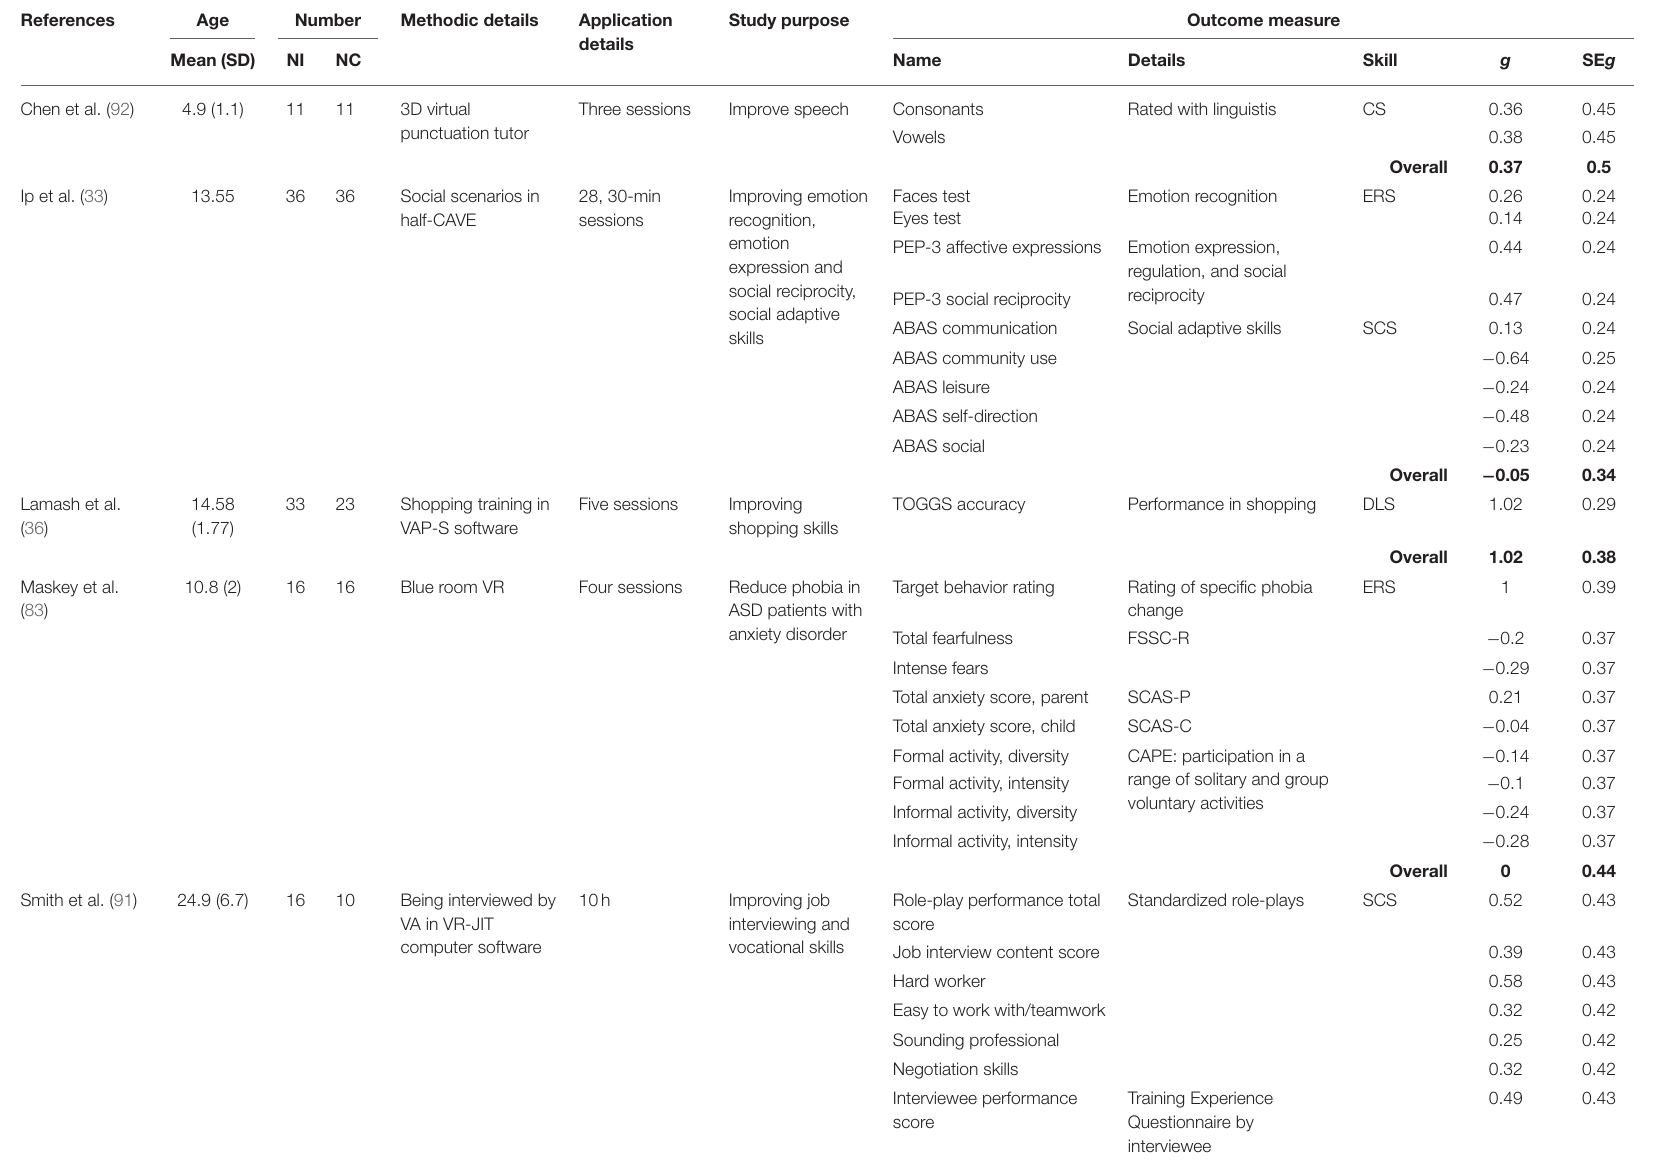
TABLE 2 | Characteristics of included studies, controlled